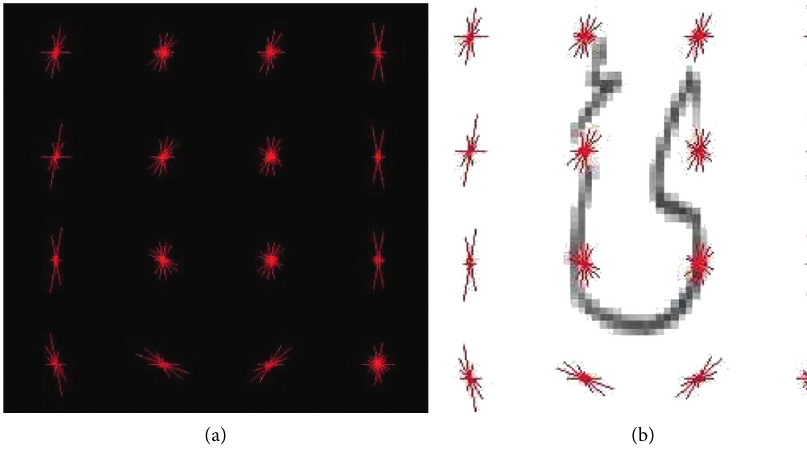
Figure 6: (a) HOG feature of the letter “ye.” (b) HOG feature of letter “ye” over it.